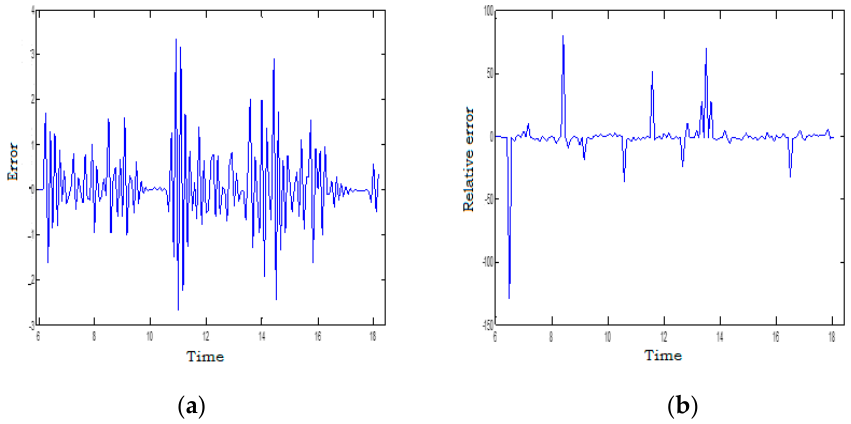
10 of 29 Figure 10. Solar radiation evolution modeled by ARMA (3,3) for a summer day. In Figure 11, the prediction errors are presented. MSE, MAE, and RMSE are calcu-